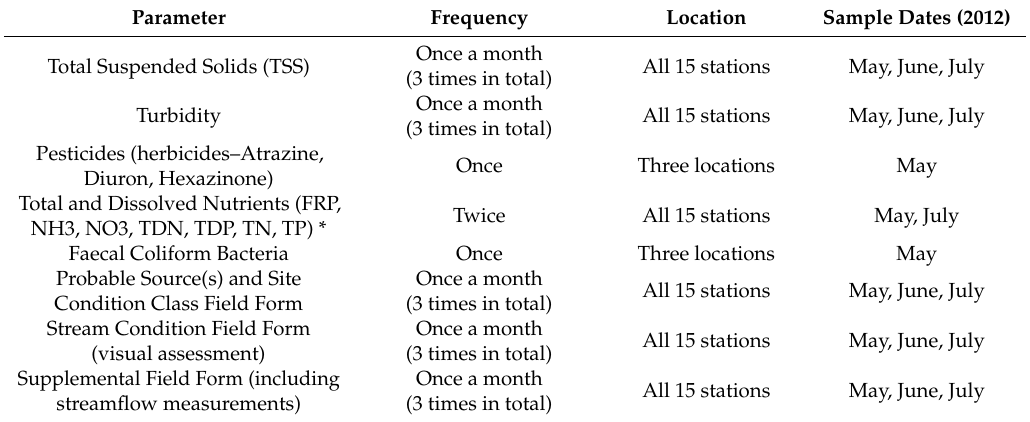
Table 1. Overview of the Pilot Water Quality Monitoring Program for the Tully Basin.